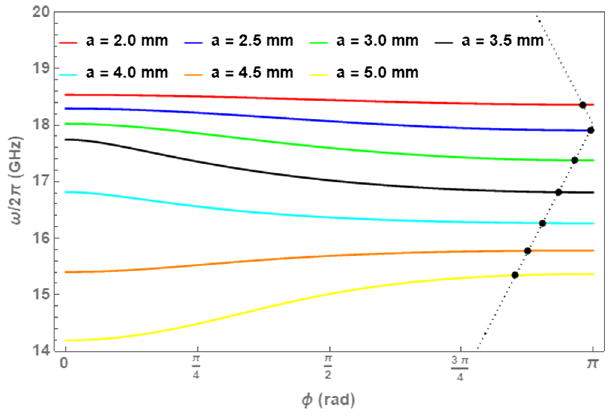
FIG. 7. The lowest dipole mode dispersion relations for a range of iris radii a where the light line (the modes that are synchronous with the beam) is shown with a dotted line. The synchronous dipole frequencies are shown as black dots.